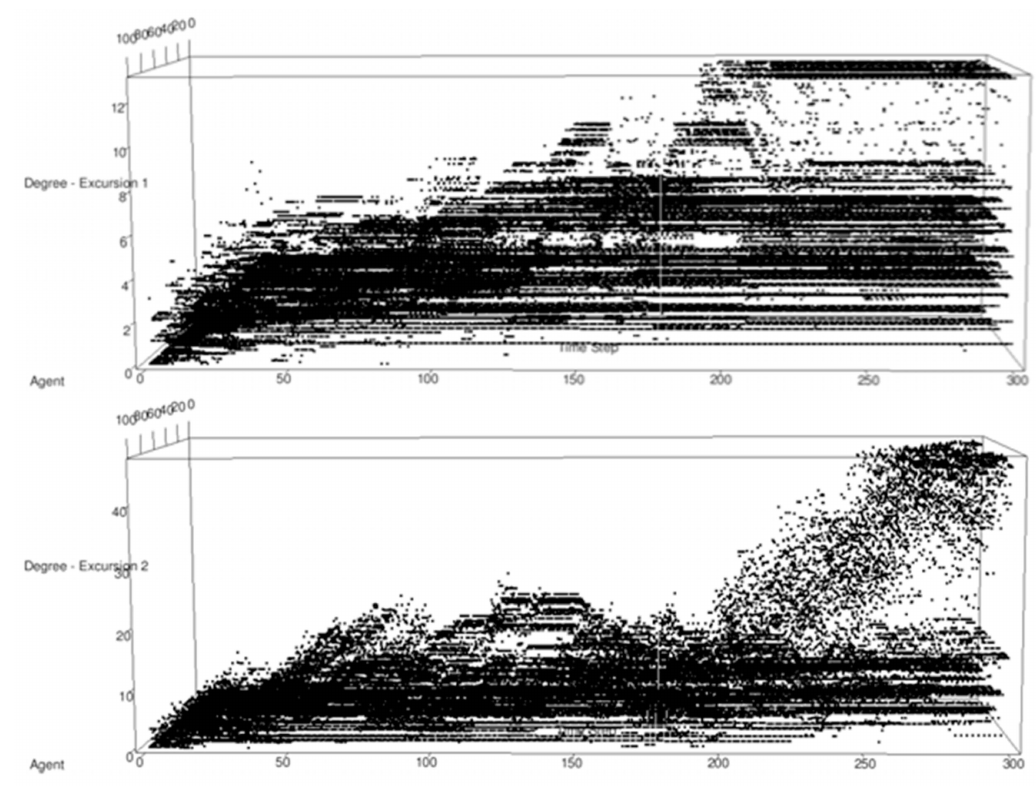
Figure 7. CliqueCreator excursion time series. Two excursion described in